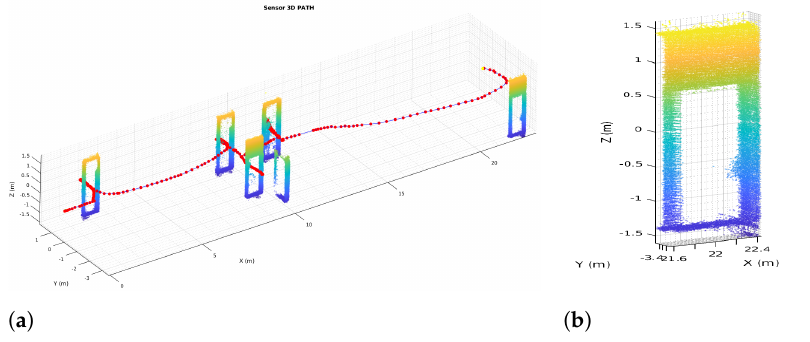
Figure 15. Door extraction. ( a ) SLAM path and Doors. ( b ) Single